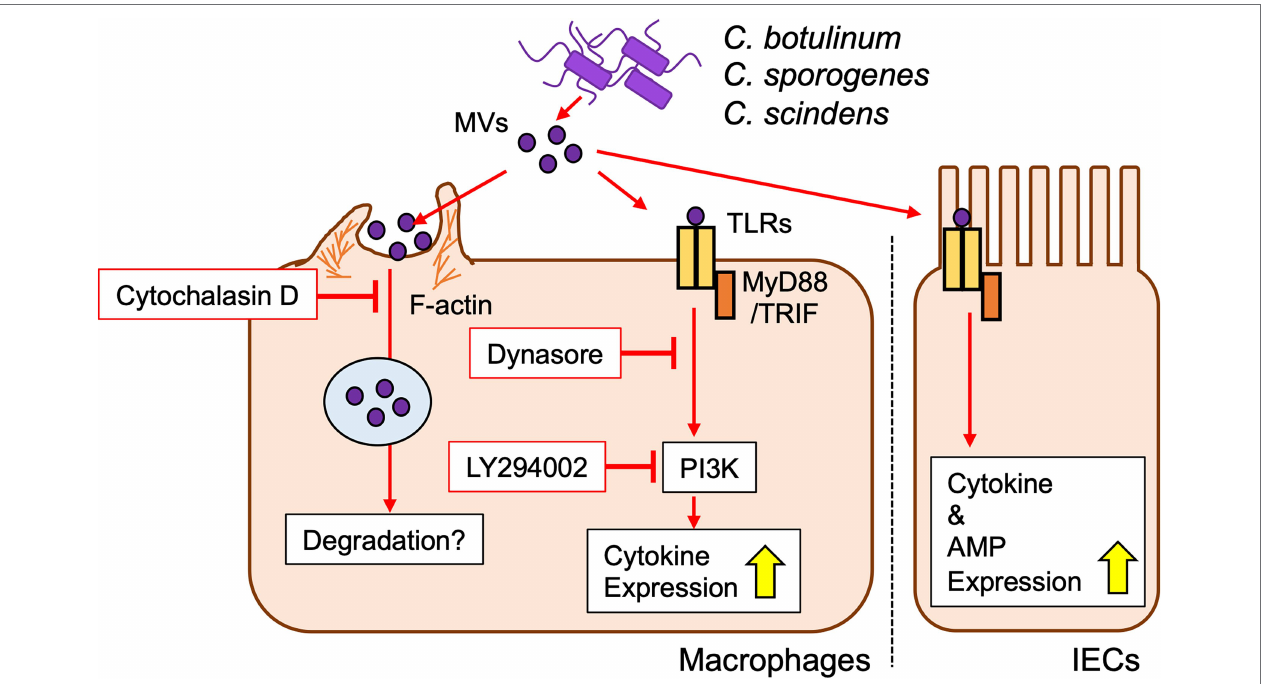
FIGURE 7 | Proposed model of innate immune responses against clostridial MVs in macrophages and